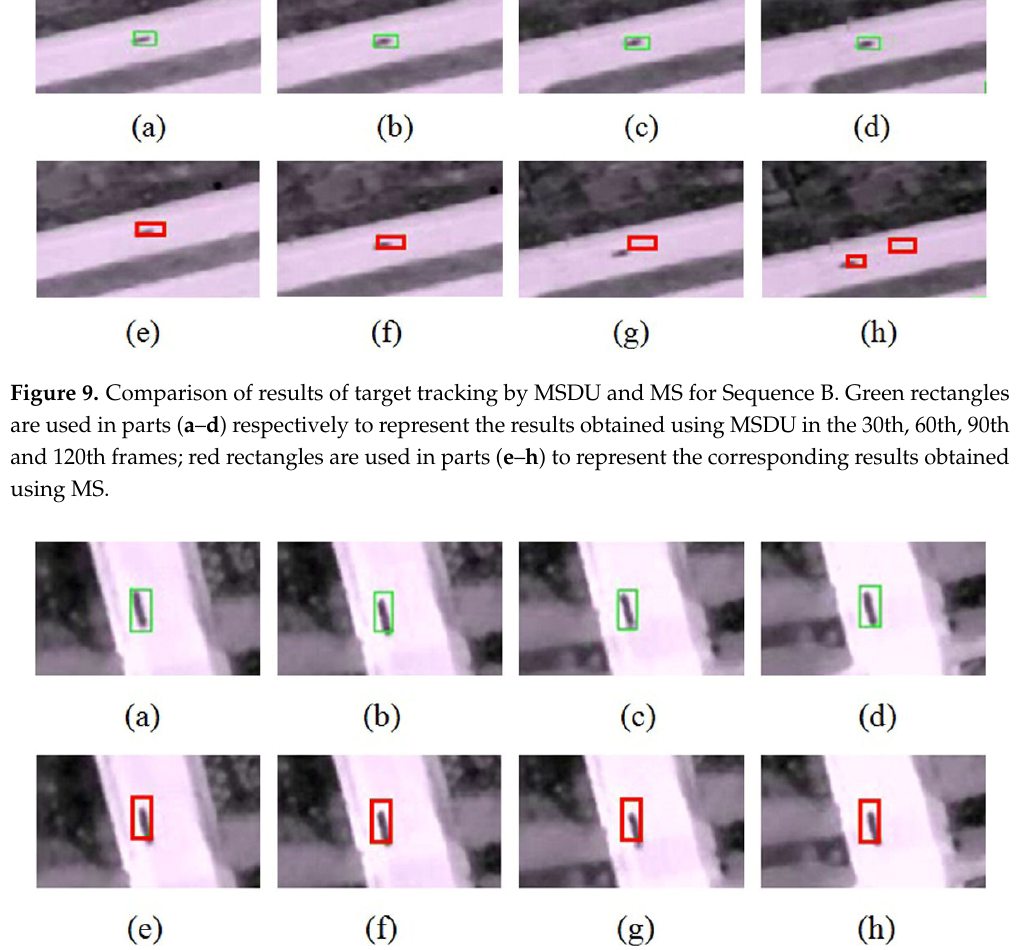
Figure 10. Comparison of results of target tracking by MSDU and MS for Sequence C. Green rectangles are used in parts ( a – d ) respectively to represent the results obtained using MSDU in the 30th, 60th, 90th and 120th frames; red rectangles are used in parts ( e – h ) to represent the corresponding results obtained using MS.